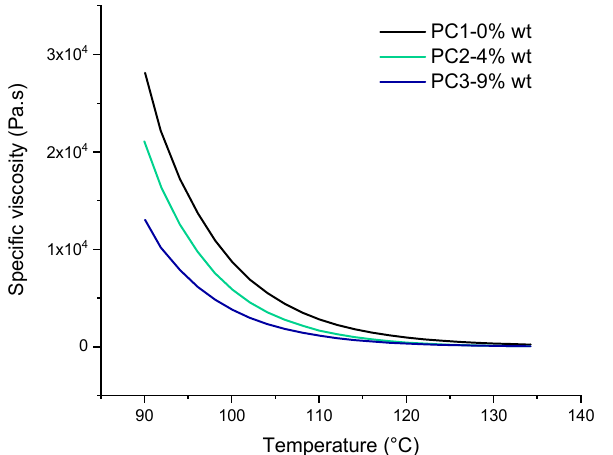
Figure 6. The specific viscosity of uncured basic urethane powders upon heating from 90 to 135 °C.